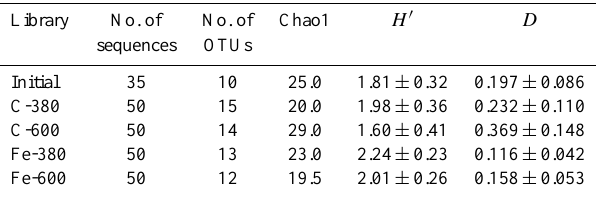
Table 2. Number of OTUs, richness index, and diversity indices (value ± 95% confidence interval) for rbcL cDNA libraries ob- tained from the initial seawater and the incubation bottles on day 2 (Fe-380 and Fe-600) and day 3 (C-380 and C-600).